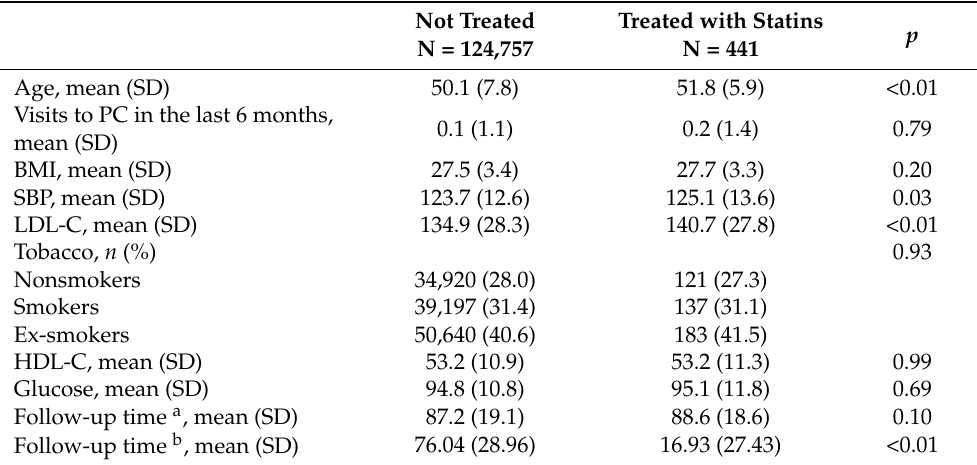
Table 3. Characteristics of the total subject-trials in the